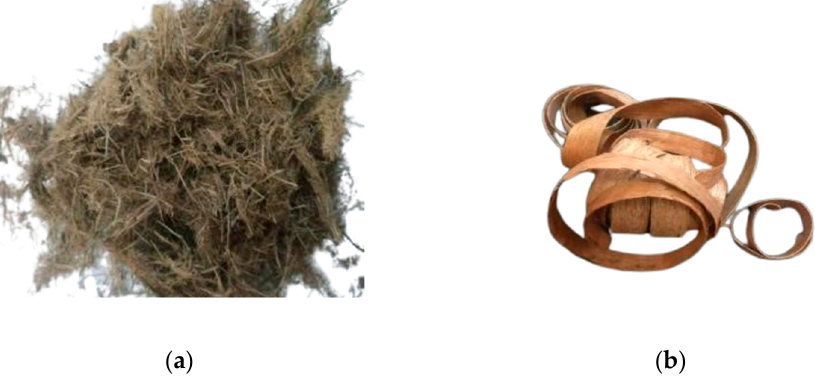
Figure 1. ( a ) The elephant dung fibers and ( b ) wood shavings in this study.